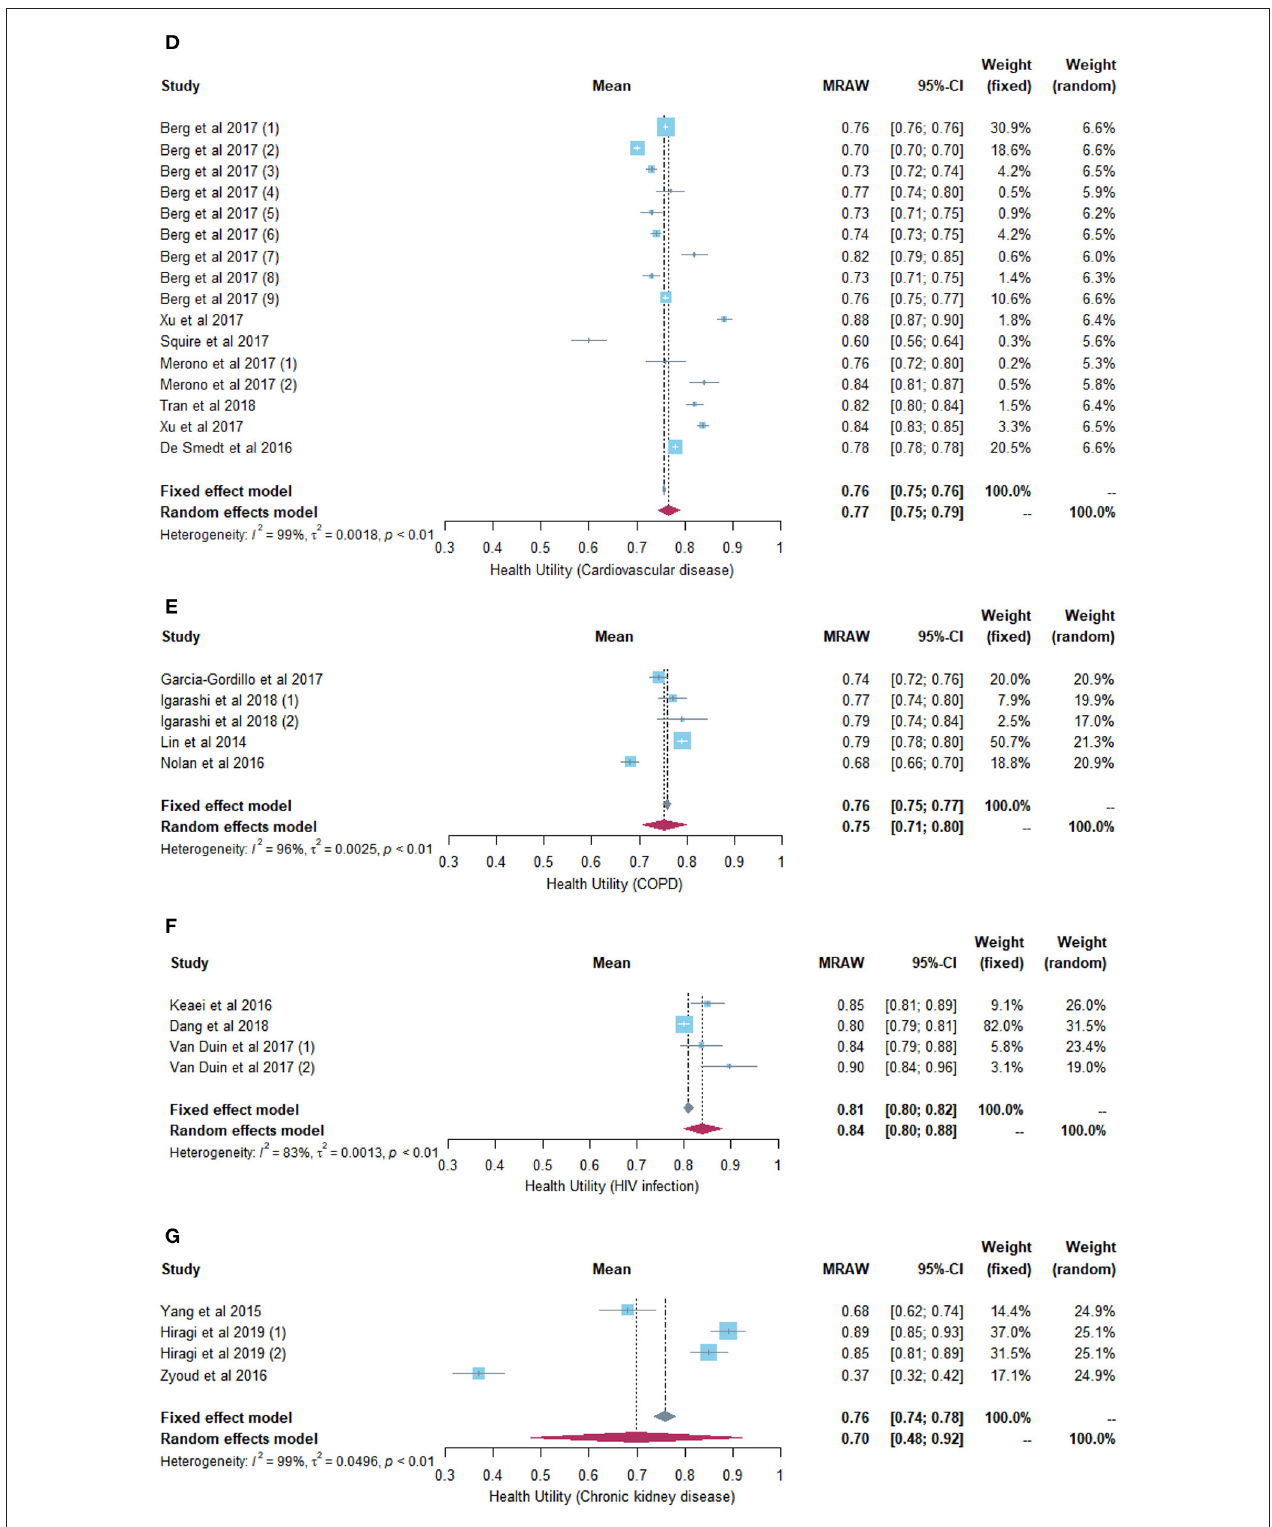
FIGURE 2 | (A) Forest plot of the health utility of patients with diabetes mellitus. (B) Forest plot of the health utility of patients with neoplasms. (C) Forest plot of the health utility of patients with multiple sclerosis. (D) Forest plot of the health utility of patients with cardiovascular diseases. (E) Forest plot of the health utility of patients with chronic obstructive pneumonia disease. (F) Forest plot of the health utility of patients with human immunodeficiency virus infection. (G) Forest plot of the health utility of patients with chronic kidney disease.